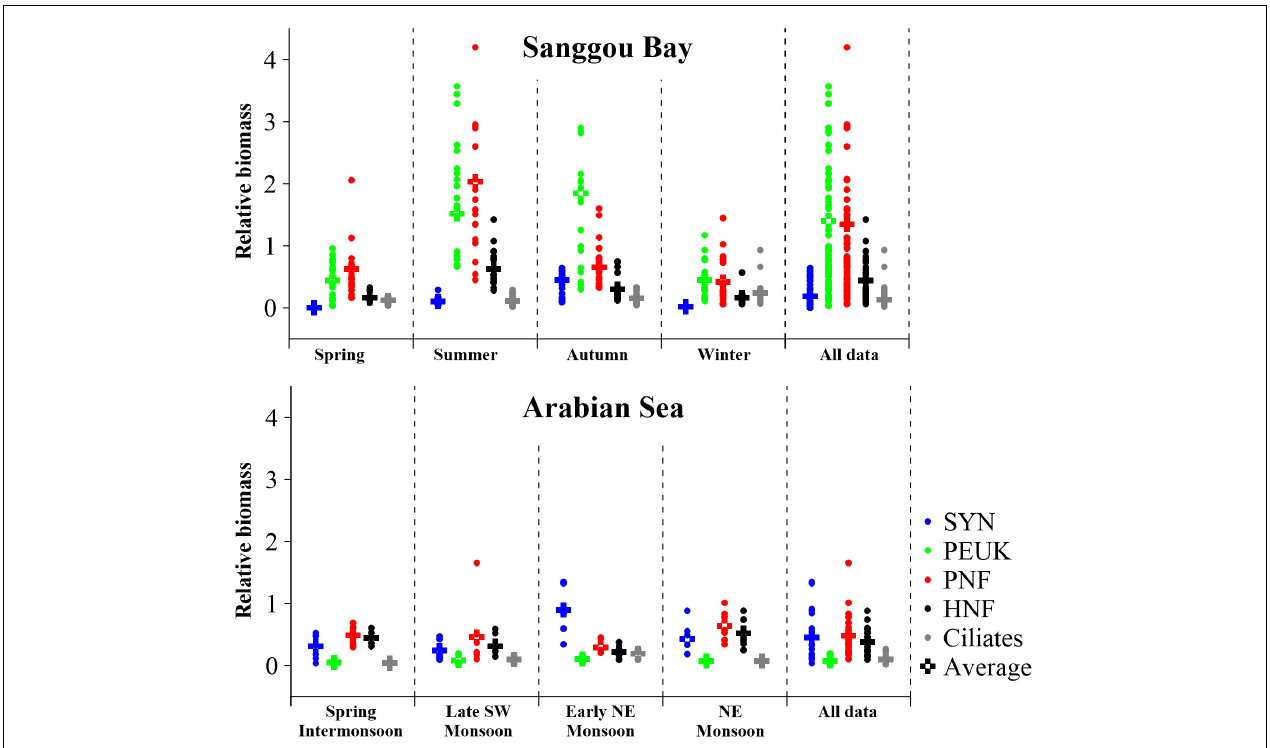
FIGURE 6 | Microbial food web structures in Sanggou Bay and Arabian Sea in four successive seasons and Monsoon stages, respectively. The data of Arabian Sea were extracted from Garrison et al. (2000). The relative biomasses of the MFW components were normalized by the HP biomass belonging to the same sample. SYN, Synechococcus ; PEUK, phototrophic picoeukaryotes; PNF, pigmented nanoflagellates; HNF, heterotrophic nanoflagellates.